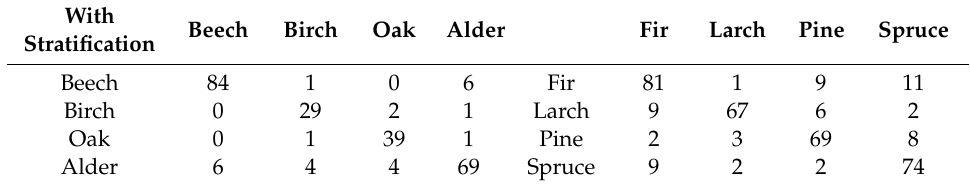
Table 6. Confusion matrix for the stratified approach based on combination of multi-temporal Sentinel-2 and topographic features, where broadleaf tree species and coniferous tree species were classified separately, each of them inside either broadleaf or coniferous forest